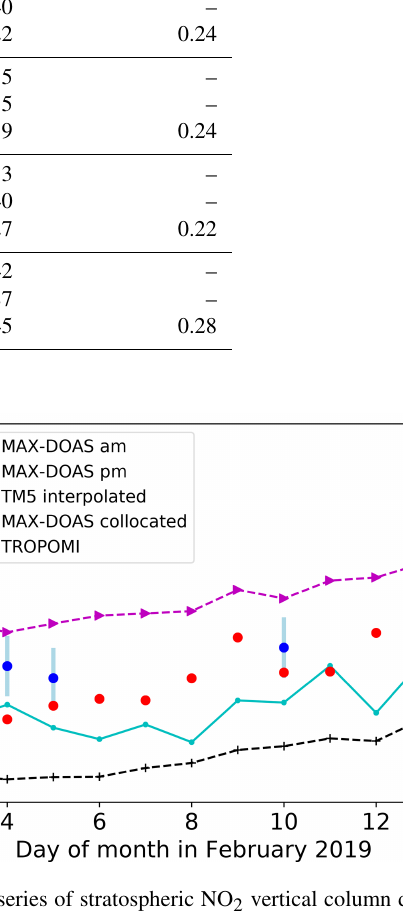
Figure 6. Time series of stratospheric NO 2 vertical column densi- ties for the cruise in February 2019. The abbreviations “am” and “pm” represent MAX-DOAS NO 2 vertical column density mean values between a solar zenith angle of 75 and 89 ◦ in the morning and in the evening, respectively. The missing TROPOMI data are due to clouds. The error bar shows the precision of the TROPOMI stratospheric NO 2